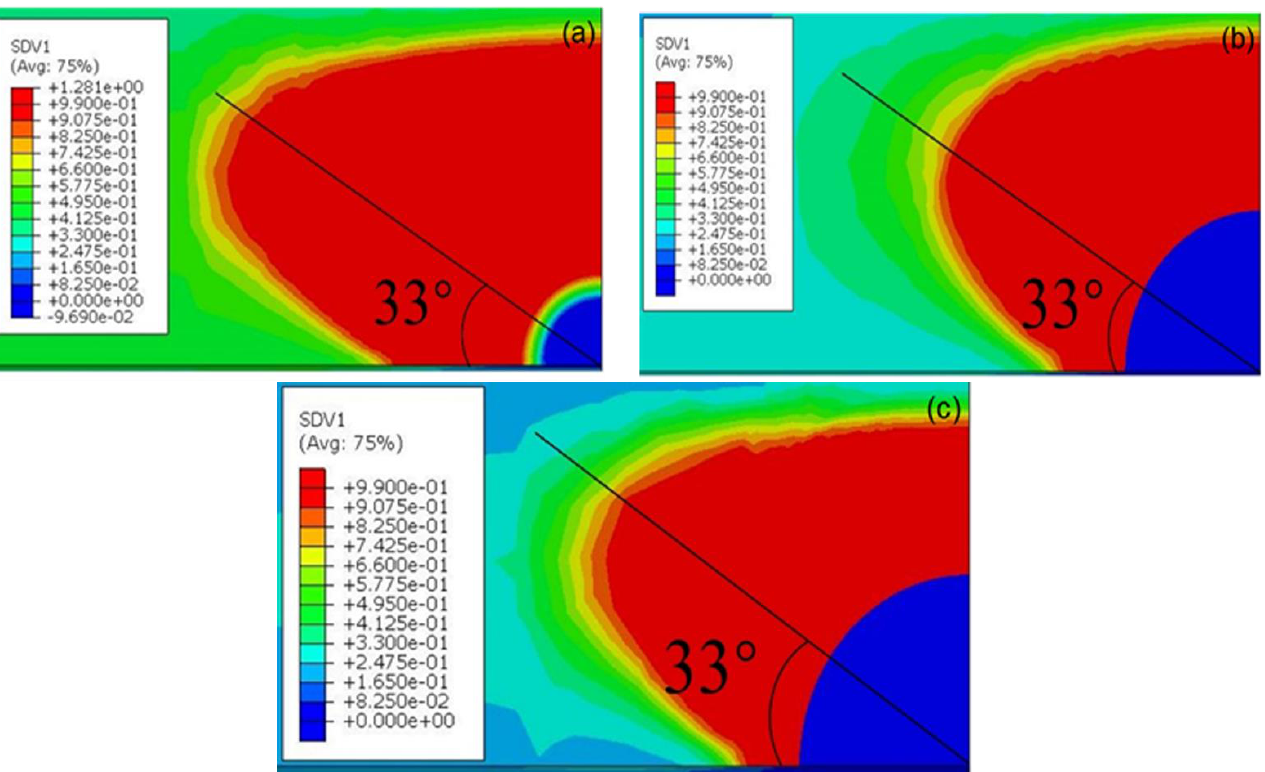
Figure 15. The damage distribution around the creep crack tip ( a ) a 0 / t = 0.2, ( b ) a 0 / t = 0.3 and ( c ) a 0 / t = 0.4.